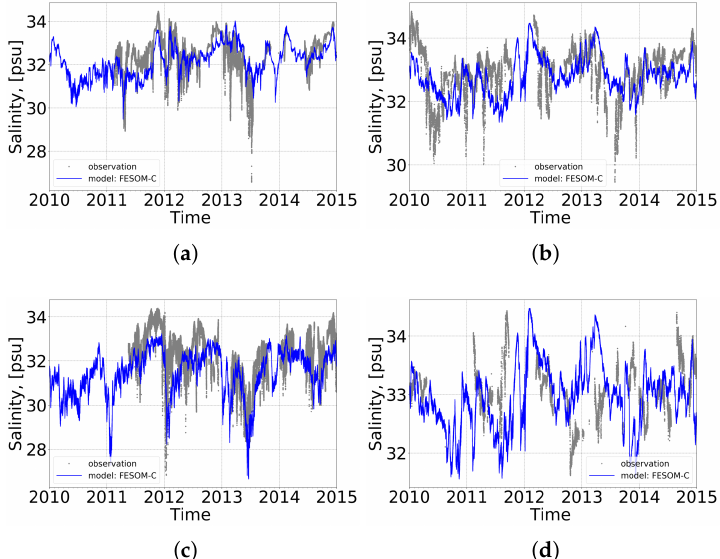
Figure 7. Comparison of observed (grey dots) and simulated (blue line) salinity at three stations: ( a ) data from the Helgoland station at 1 m depth; ( c ) data from the Brouwershavensegat station at 1 m depth; and ( b , d ) data from the UFS Deutsche Bucht station at 6 and 30 m depth,